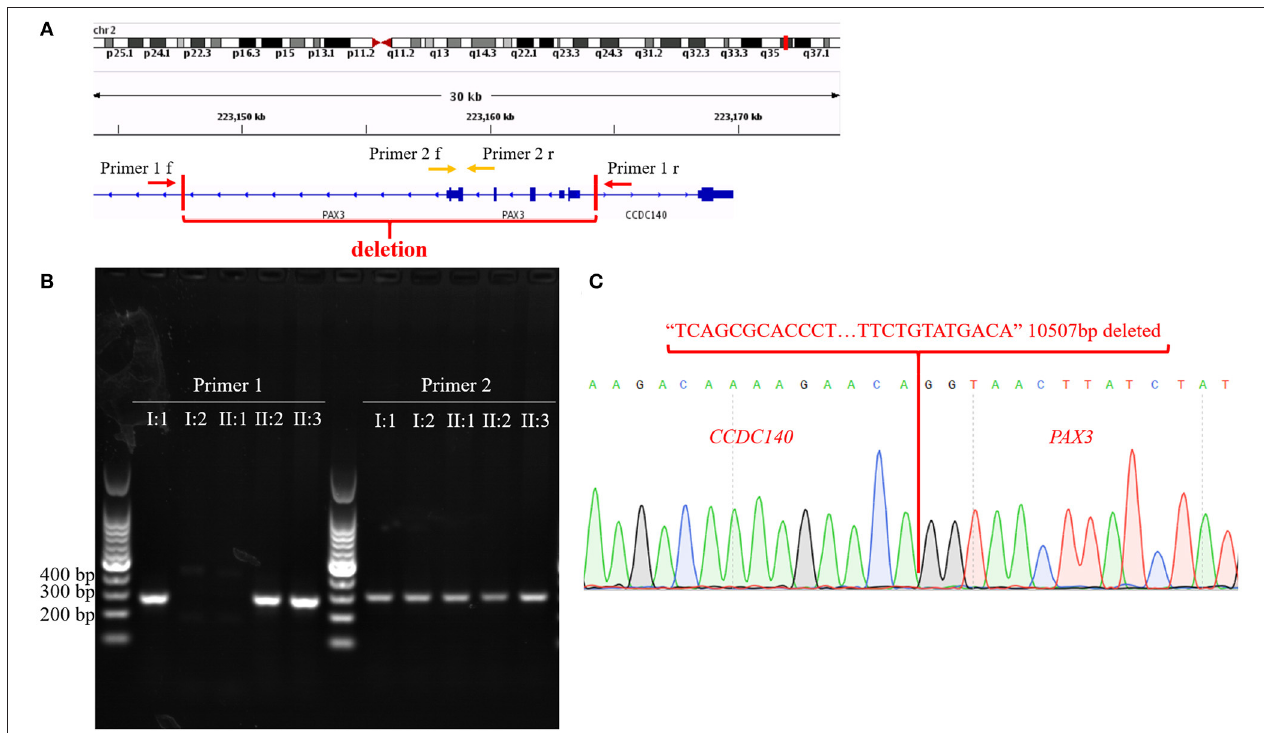
FIGURE 4 | (A) The diagram of primer 1/2 pairs design. Arrows represent primer pairs; red vertical lines cut out the region of the structural variant. (B) Agarose gel electrophoresis results. (C) Sequencing results of sequences amplified according to Primer 1. Red sequence represents deleted sequence; red words indicate genes that correspond to the